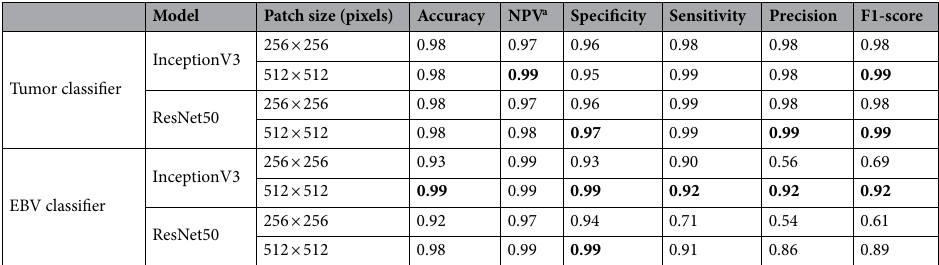
Table 1. Patch-wise model performances in the tumor classifier (upper) and the EBV classifier (lower). Bold font: maximum value of specific metrics across different model and patch size. a Negative predictive value.